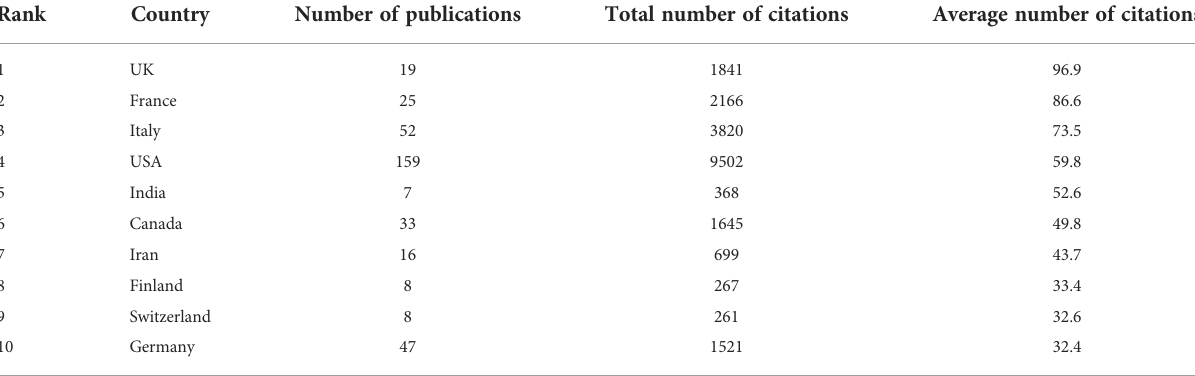
TABLE 3 The top 10 countries with the highest average number of citations per article from 707 retrieved list in the links of gut microbiota and MAFLD research from 2002 to 2021 (sorted by the average number of